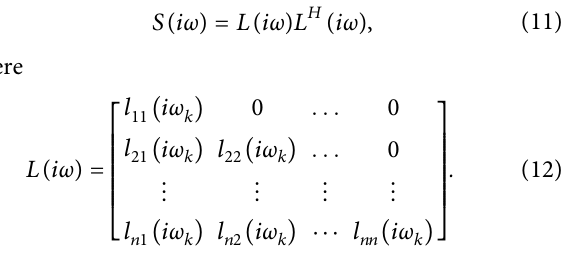
Figure 2: Power spectrum.